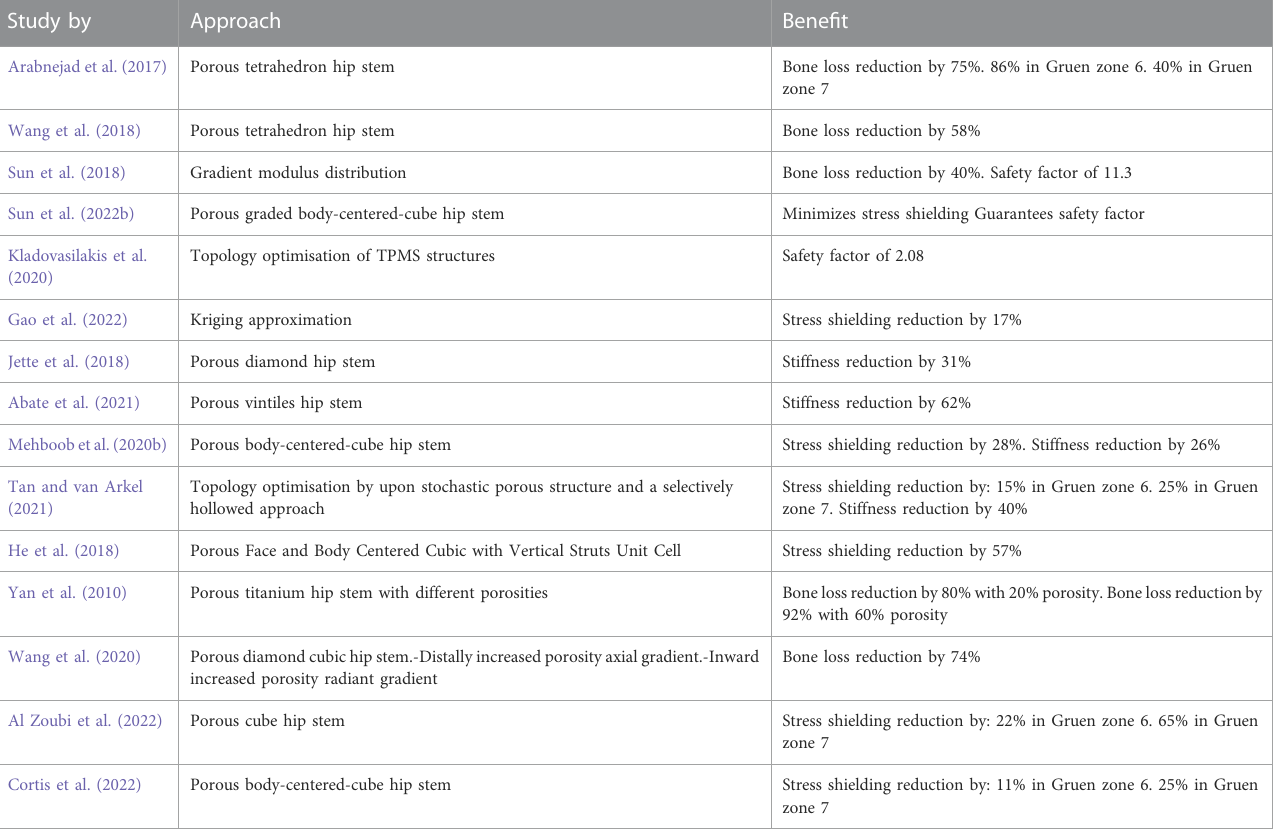
TABLE 1 Recent studies considering porous hip stem to reduce stress shielding effect and bone loss. Study